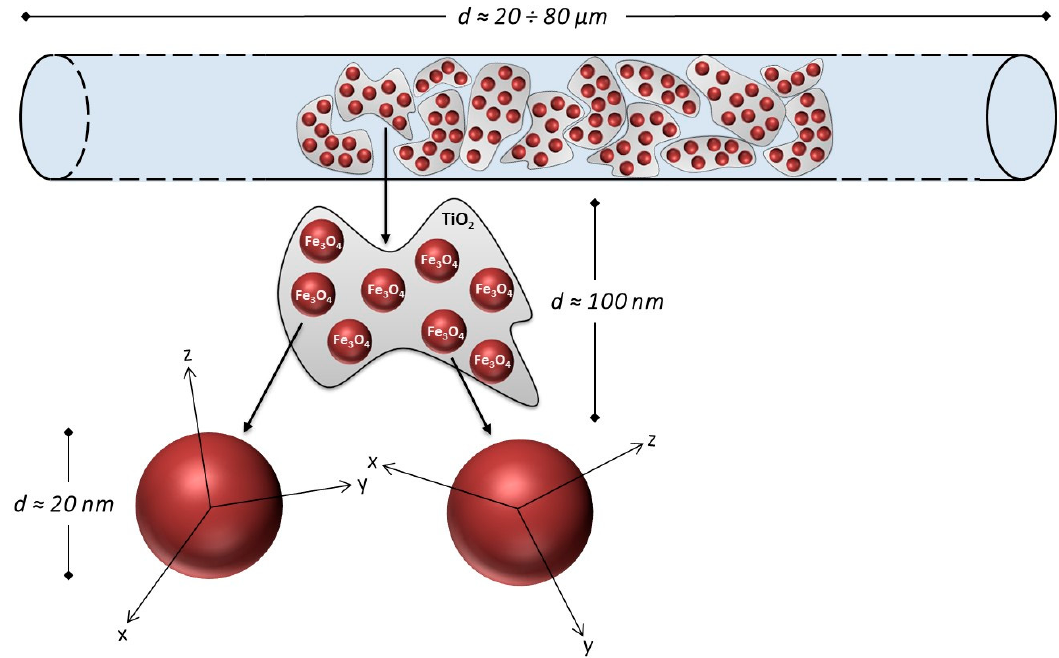
Figure 5. Morphology of a magnetic chain in the Fe 3 O 4 @TiO 2 NC (not to scale). Within the chain, the crystal axes of magnetite NPs are randomly directed. Reprinted in modified form from the work of [41] with permission from Elsevier.